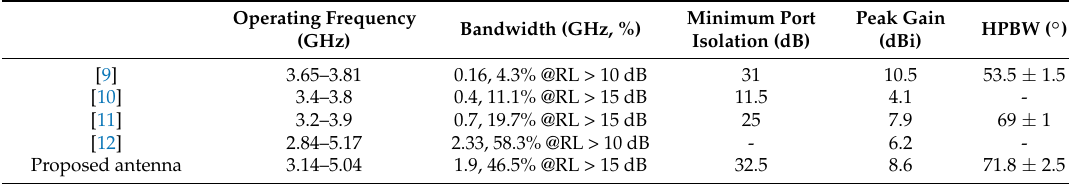
Table 1. Performance